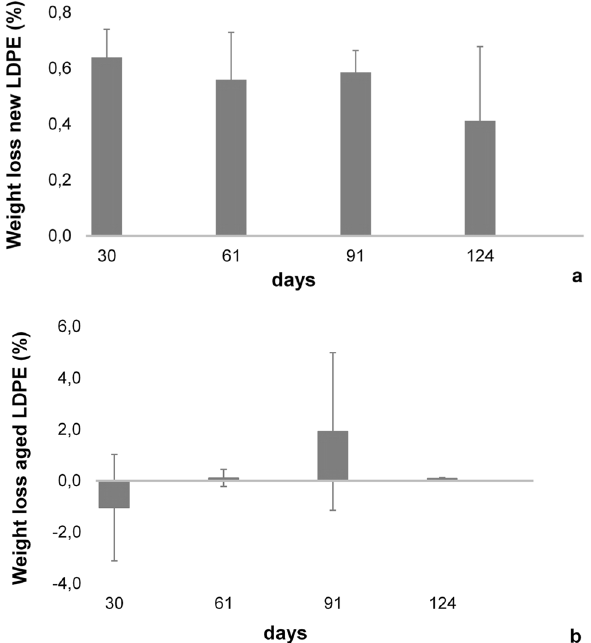
Fig. 2 Percentage on Weight loss in new LDPE samples ( a ) and aged LDPE samples ( b ), both composted during 30, 61, 91,